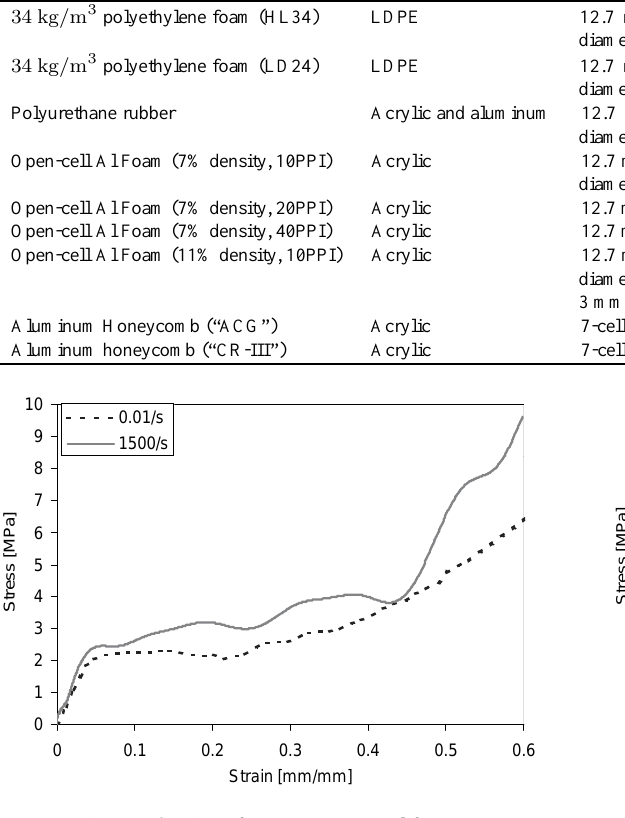
Fig. 5. Behaviour of 11%, 10PPI Duocel foam. Fig. 6. Behaviour of 7%, 40PPI Duocel